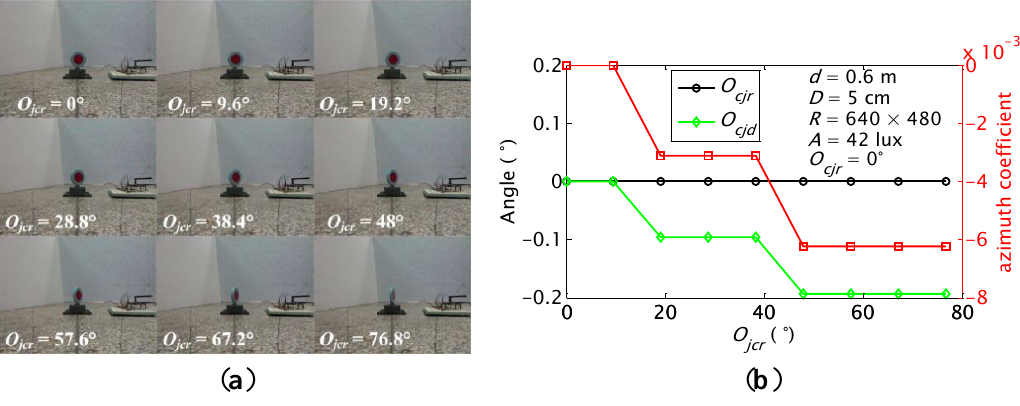
Figure 14. Azimuth coefficient and orientation detection results of the carrier when the orientation of the JSN is set as different values: ( a ) recorded images; ( b ) calculated ζ and O cj